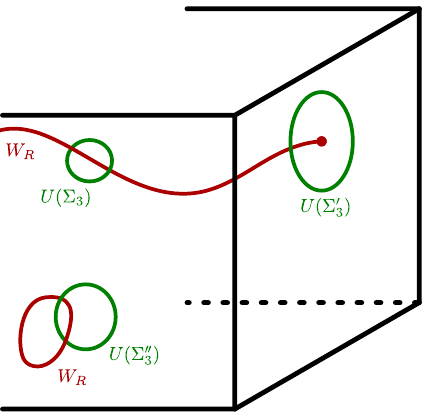
Figure 2: Artistic impression of 5d Maxwell Theory with boundaries. Wilson lines W charged under U ( 1 ) ( 1 ) R